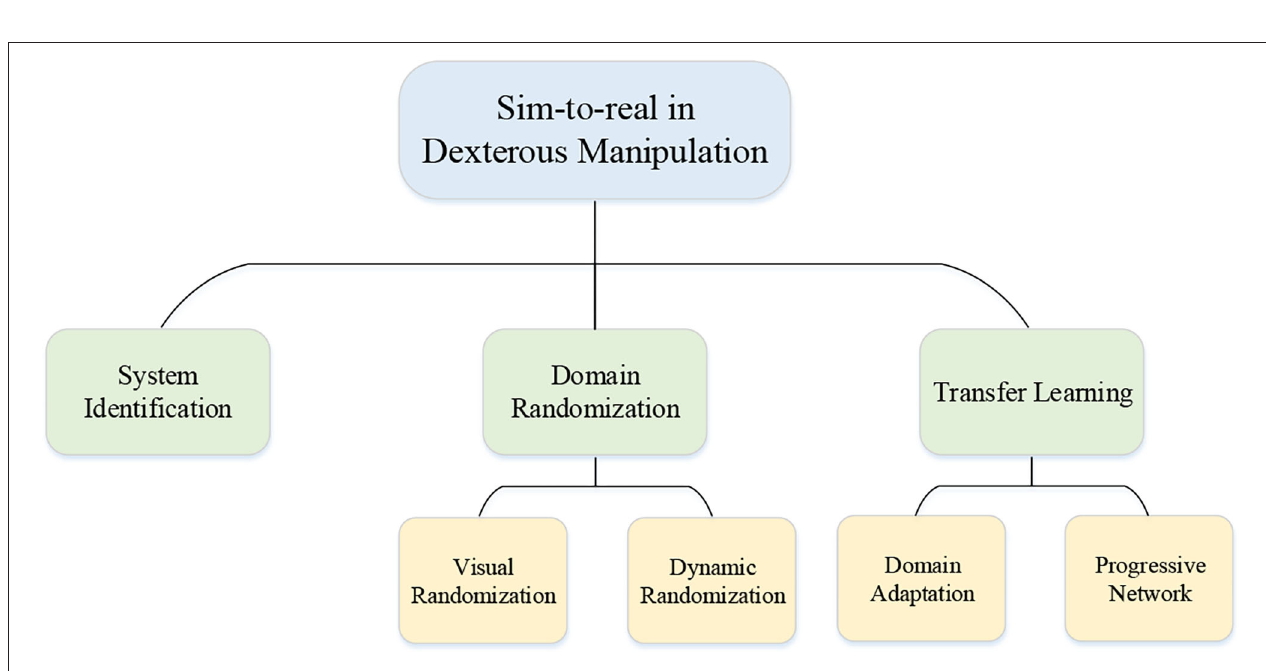
FIGURE 7 | Category of approaches for sim-to-real in this